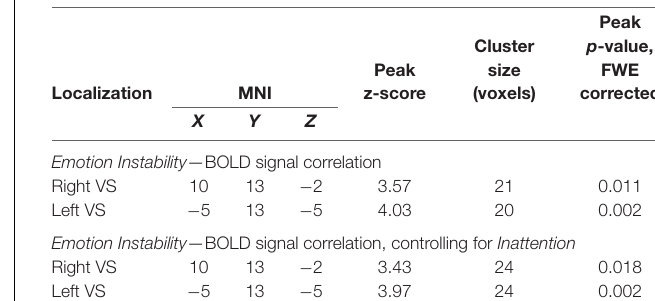
FIGURE 4 | Reward outcome Win vs. Baseline . Uncorrected, p < 0.001, clusters > 20 voxels. Activations are overlaid on an average T1 image based on our 29 participants. Task activations (red color) overlap with activations in the study by Bayard et al., 2018 (blue color) in bilateral insula and rACC. For the exact location of activations, see Supplementary Table S4 .